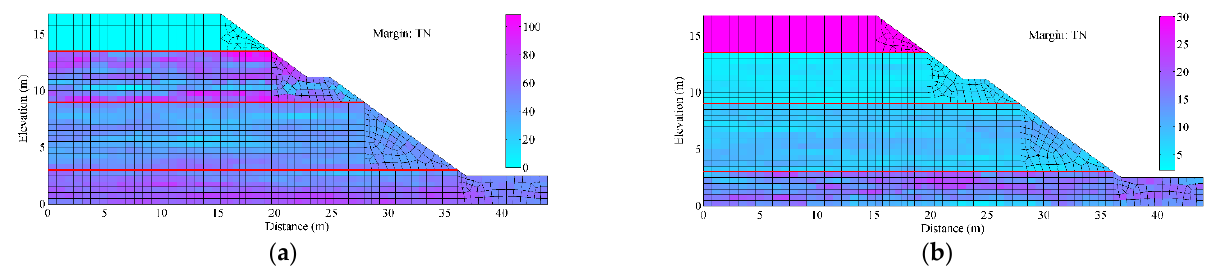
Figure 21. A typical realization of transversely anisotropic CCRF yielded by strategy 5. ( a ) Random field of c. ( b ) Random field of ϕ.